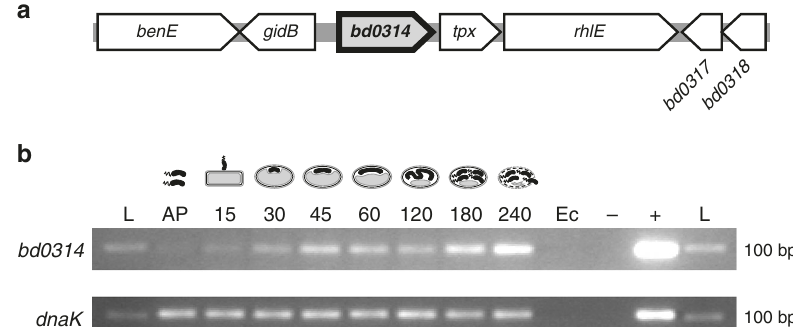
Fig. 1 Transcriptional expression and genomic context of lysozyme homolog-encoding bd0314 . a Scheme of the genomic context of bd0314 including surrounding genes predicted to encode a benzoate membrane transport protein ( benE ), a glucose-inhibited division protein B ( gidB ), a thiol peroxidase ( tpx ), an ATP-dependent RNA helicase ( rhlE ), and two hypothetical proteins ( bd0317 , bd0318 ). b Transcriptional analysis by reverse transcriptase PCR showing the expression of lysozyme gene homolog bd0314 and housekeeping gene dnaK , during the host-dependent lifecycle of B. bacteriovorus HD100 as depicted in drawings above the agarose gel. AP: attack phase HD100 cells, 15 – 240: timepoint in minutes after the invasion, Ec: E. coli S17-1 prey cells, − : negative control with H 2 O, + : positive control with genomic DNA of B. bacteriovorous HD100, L: 100 bp DNA ladder. This fi gure shows one of two biological repeats with similar results.